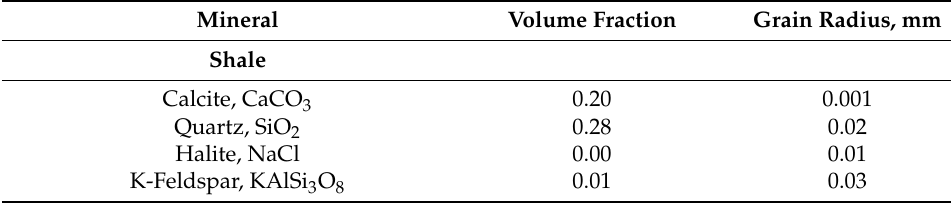
Table 4. The initial and boundary formation lithology and